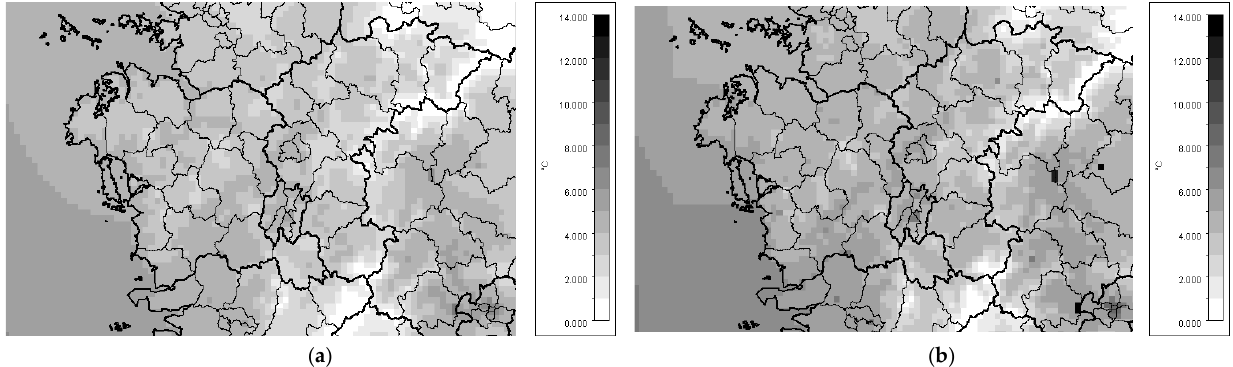
Figure 13. Spatial distribution of monthly mean ( a ) temperature at 2 m and ( b ) surface temperature in Chungcheong.